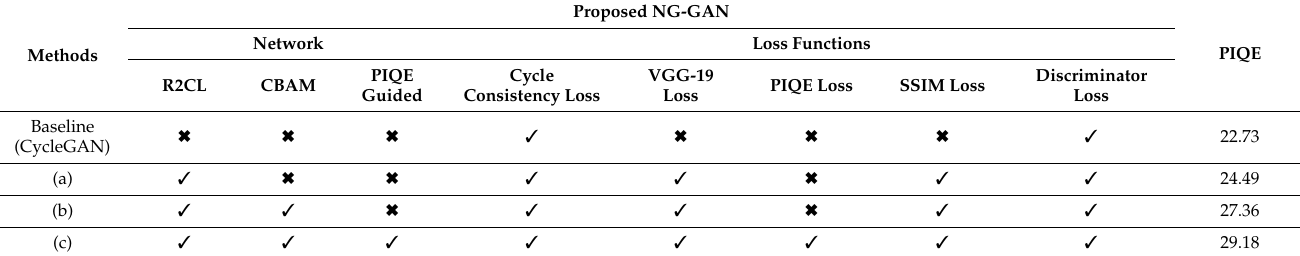
Table 3. Results for ablation study. (a) Baseline (CycleGAN Network), (b) only R2CL generator in the proposed NG-GAN model, (c) R2CL generator with CBAM in the proposed NG-GAN model, (d) R2CL generator with CBAM and PIQE metric calculated from old images concatenated to the clean images in the proposed NG-GAN